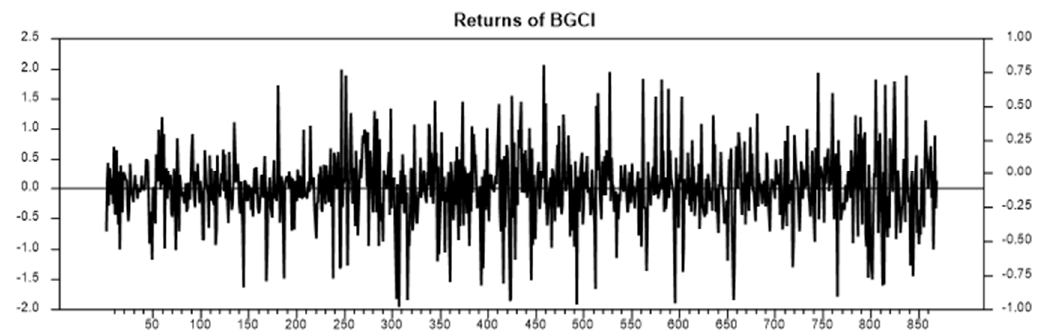
Figure 2. Returns of BGCI.